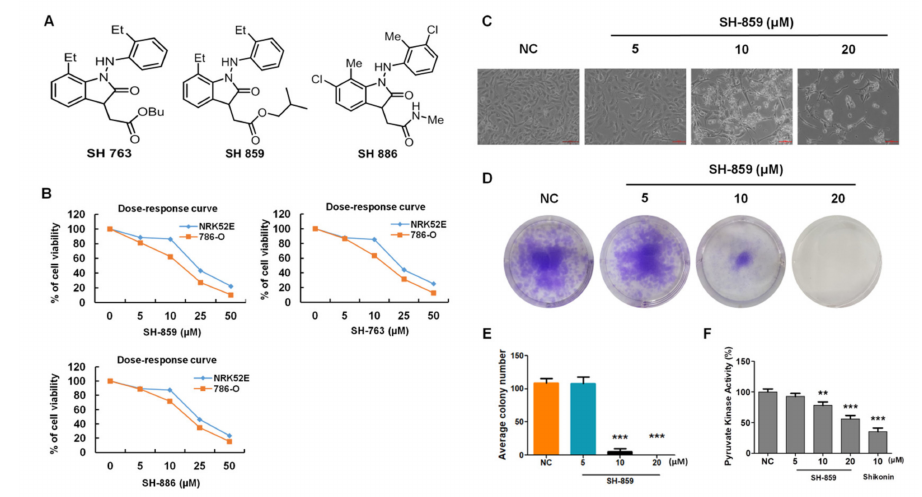
Figure 1. Consequences of oxindole derivative treatment on the survival, morphology, and colony formation ability of 786-O cells. ( A ) The chemical structures of various oxindole derivatives active against 786-O cells. ( B ) Dose–response curve of oxindole derivatives on the viability (determined using 3-(4,5-dimethyl-2-thiazolyl)-2,5-diphenyl-2H-tetrazolium bromide (MTT) assay) of kidney cancer 786-O cells and their subsequent treatment with indicated small molecules at concentrations ranging from 5–50 µ M for 48 h. IC 50 was determined by SigmaPlot software. Small molecules reduced the survival of 786-O cells as compared with normal control (untreated 786-O cells) and normal kidney cells (NRK52E). ( C ) The morphology of normal control (untreated 786-O cells) and SH-859-treated 786-O cells. The morphological variations were observed after oxindole derivative (SH-859) treatment as compared with normal control (untreated 786-O cells). ( D ) Images of the colony formation assay of 786-O cells treated with SH-859 in six-well plates. 786-O cell colonies were visually verified and counted under a light microscope. No di ff erences in colony numbers were observed between the normal control (untreated 786-O cells) and the SH-859 (5 µ M)-treated cells as compared with those treated with higher concentrations of SH-859. ( E ) Quantitative estimation of colony number. ( F ) Evaluation of SH-859 treatment on pyruvate kinase activity in 786-O cells. Shikonin (10 µ M) was used as a positive control. Representative records of three independent experiments ( n = 3) are shown. One-way ANOVA was used to compare the means of di ff erent concentrations. Di ff erences between means were considered significant at p < 0.05 using Tukey’s multiple comparison test; ** p < 0.01 and *** p < 0.001 as compared with normal control (untreated 786-O cells). NC: normal control (untreated 786-O